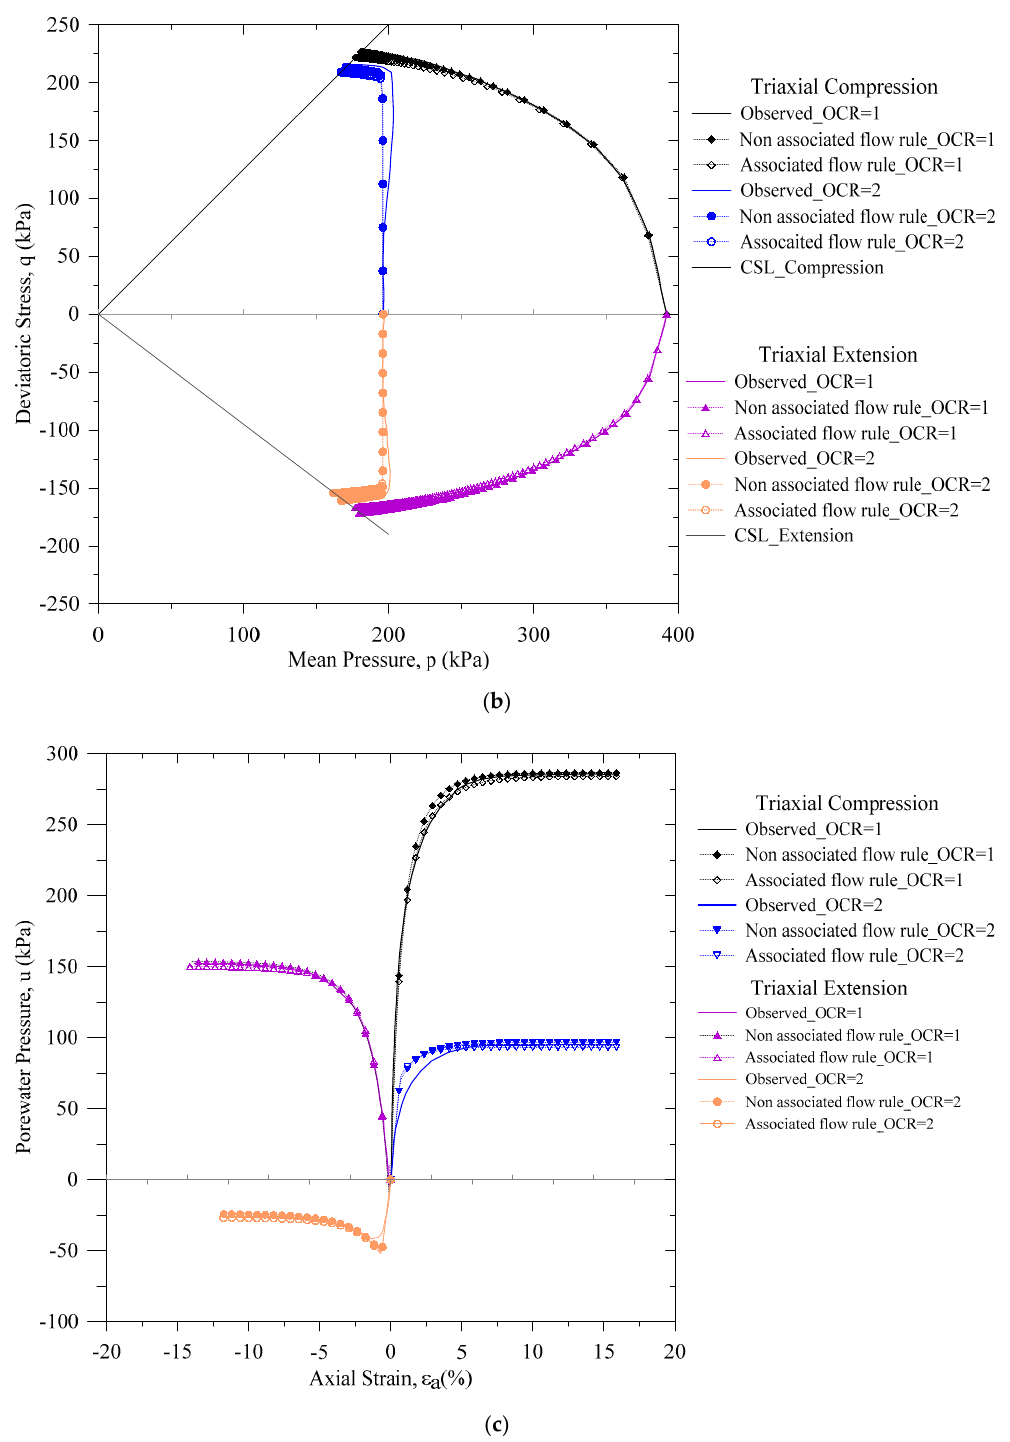
Figure 12. Comparison of observed and predicted triaxial compression test results of Kaolin Clay ( a ) Deviatoric stress-axial strain and ( b ) stress path and ( c ) pore pressure.